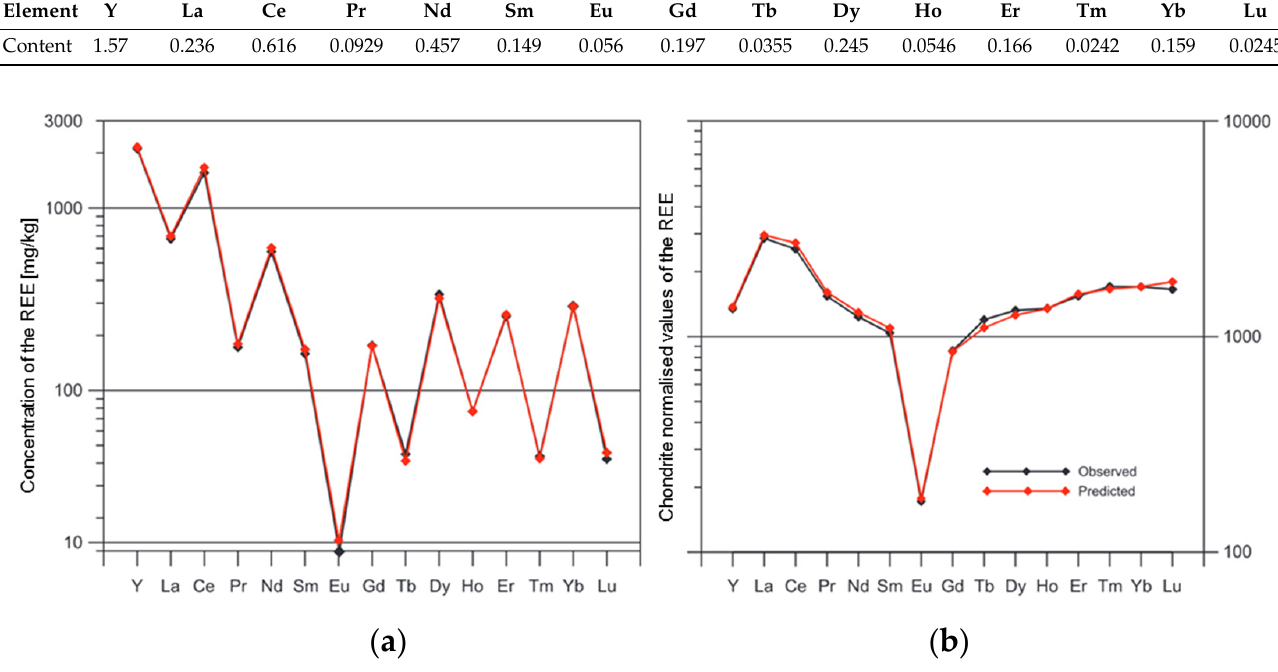
Figure 2. ( a ) Plot of the REE mass fractions (except for Sc and Pm) without normalisation and ( b ) with chondrite normalisation using the example of the “Strange Lake Intrusion” according to Kerr [26].